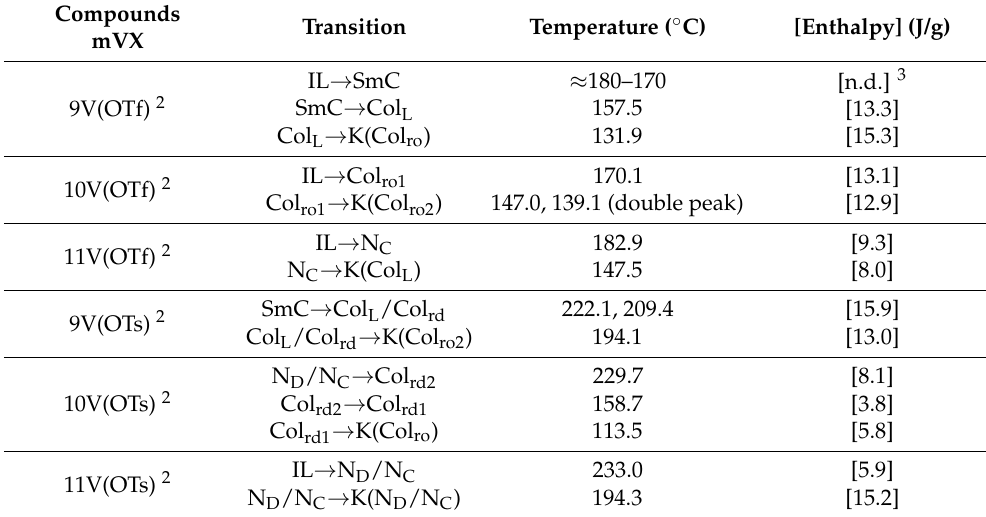
Table 1. Transition temperature and transition enthalpy values (in brackets) for the thienoviologen salts mVX 1